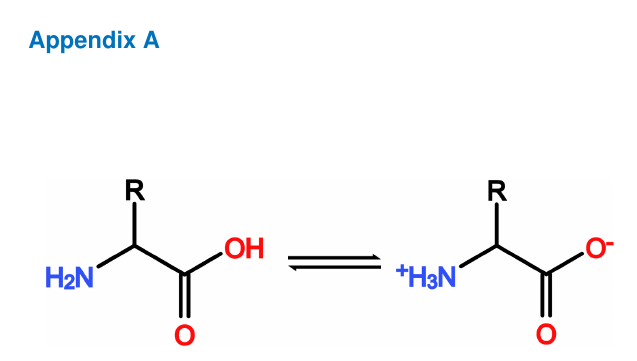
Figure A1. General reaction scheme of a zwitterionic equilibrium reaction of amino acids. In aqueous solution the H + of the carboxyl function can be released and absorbed by the amino function of the same molecule, leading to the formation of a so-called zwitte- rion. This enables amino acids to engage in strong polar interactions based on electrostatic